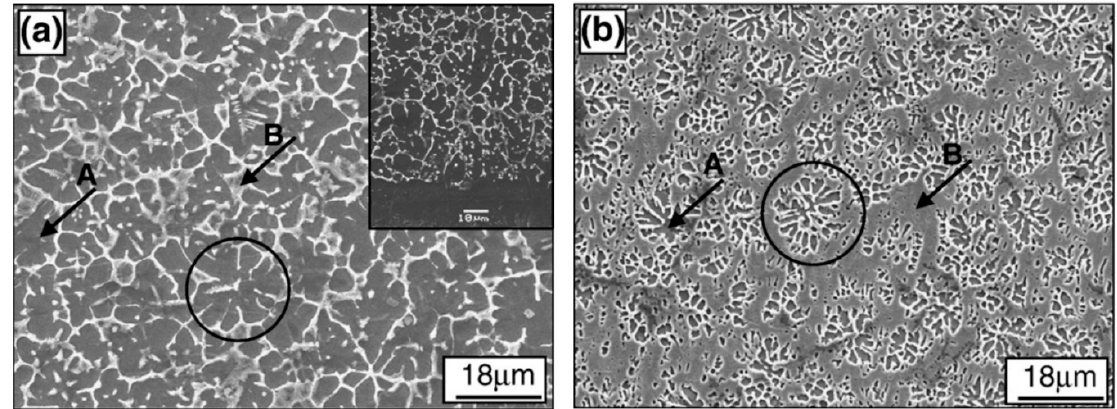
Figure 6. Cross-section microstructure of the 6FeNiCoCrAlTiSi HEA coating. ( a ) Before annealing, and ( b ) after annealing [90]. Copyright 2011 Elsevier.